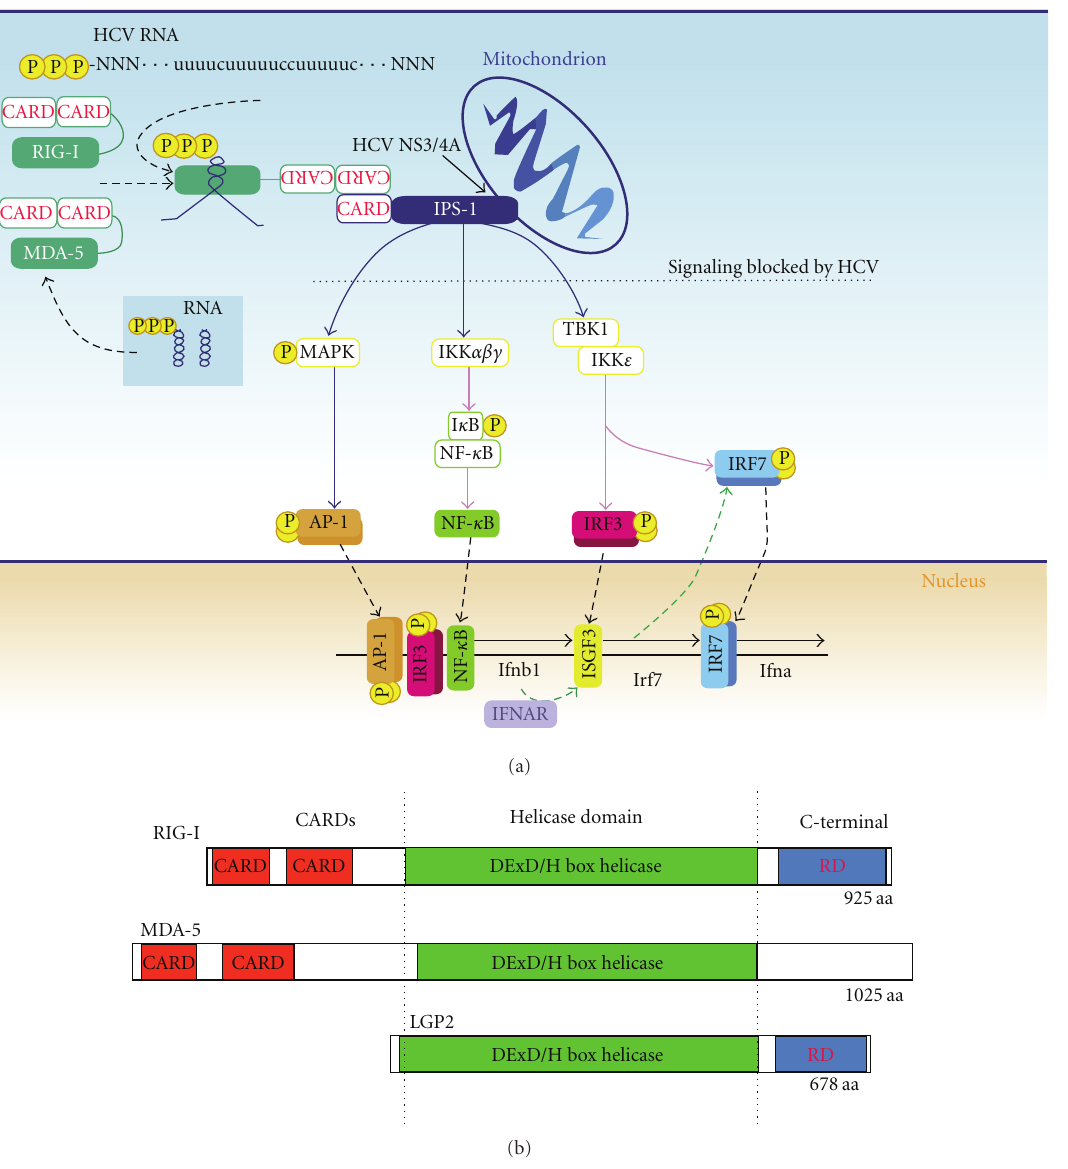
Figure 1: (a) The innate immune induction pathway through RLR activation. HCV 5 (cid:2) ppp RNA with poly-U/UC motif is shown as the RIG-I ligand RNA; 5 (cid:2) ppp dsRNA is depicted beneath MDA5 and could serve as either RIG-I or MDA5 ligand RNA. The site of NS3/4A targeting of IPS-1 within the RLR pathway during HCV infection is indicated by the arrow, and the resulting signaling blockade is indicated by the broken line. (b) The RLR family members. CARD, helicase, and C-terminal domains, including the repressor domain (RD), are indicated. Numbers refer to amino acid (aa)